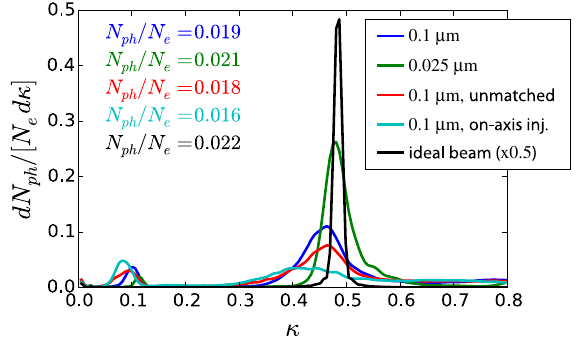
FIG. 6. Photon energy spectrum, obtained by integrating the energy-angular photon spectrum in angle from θ ¼ 0 to θ ¼ θ , given by Eq. (41), as a function of normalized natural photon energy κ for the following cases: (blue curve) optimally injected to minimize the betatron motion, matched beam, with 0 . 1 μ m normalized emittance; (green curve) optimally injected, matched beam, with 0 . 025 μ m emittance; (red curve) optimally injected, unmatched beam, with 0 . 1 μ m normalized emittance; (cyan curve) on-axis injection, matched beam, with 0 . 1 μ m normalized emittance. The black curve shows the case of an ideal beam with no transverse emittance and no energy spread. (Note that, for plotting purposes, the curve representing the ideal beam case was multiplied by a factor of 0.5.) The undulator parameters are the same as in Fig. 3(a), i.e., the exponential term in the focusing force is neglected.